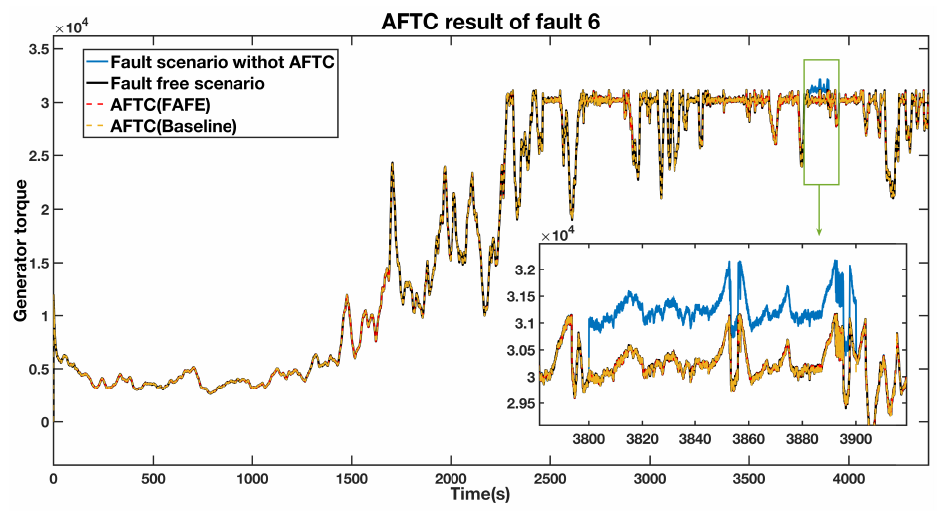
Figure 10. AFTC Results Comparison of the generator torque output.